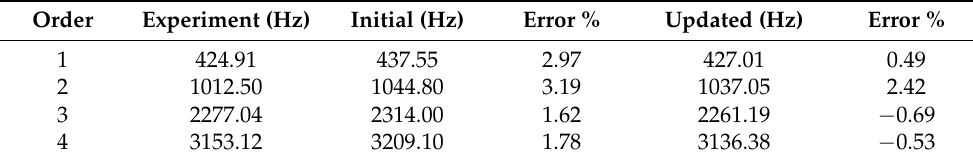
Table 7. Comparison of modal frequency errors.